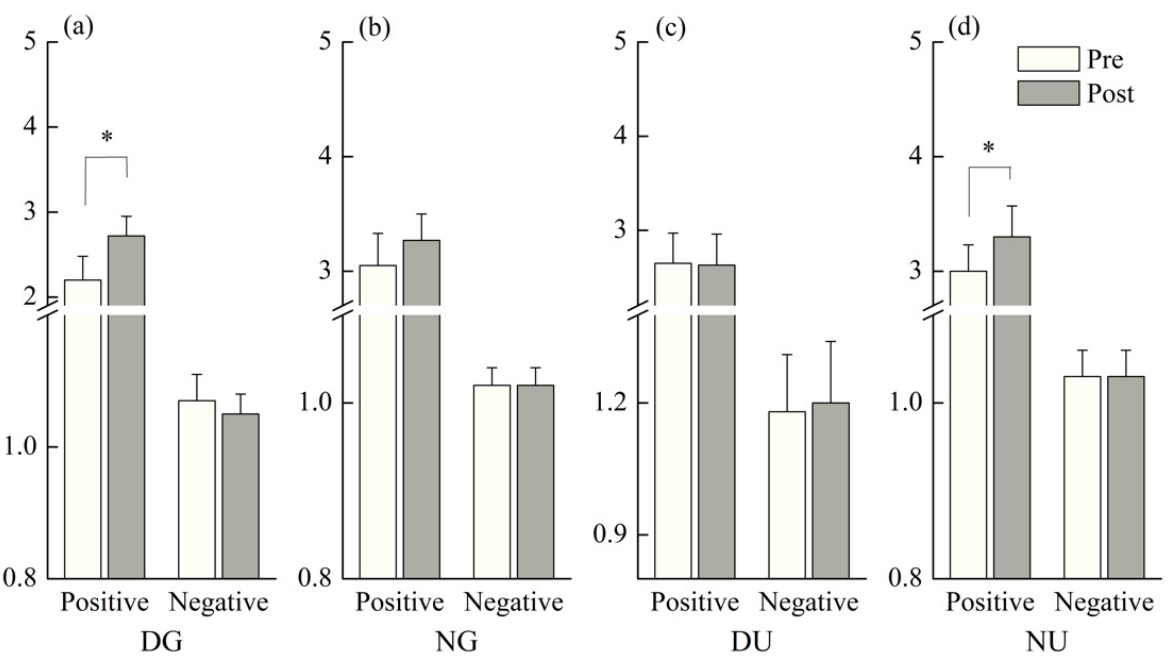
Figure 3. Outcomes of Positive and Negative Affect Schedule (PANAS) in: ( a ) daytime green walking; ( b ) nighttime green walking; ( c ) daytime urban walking; and ( d ) nighttime urban walking. The error bar represents standard error, and * represents p < 0.05. Analyzed using Wilcoxon signed-rank test ( N = 12).